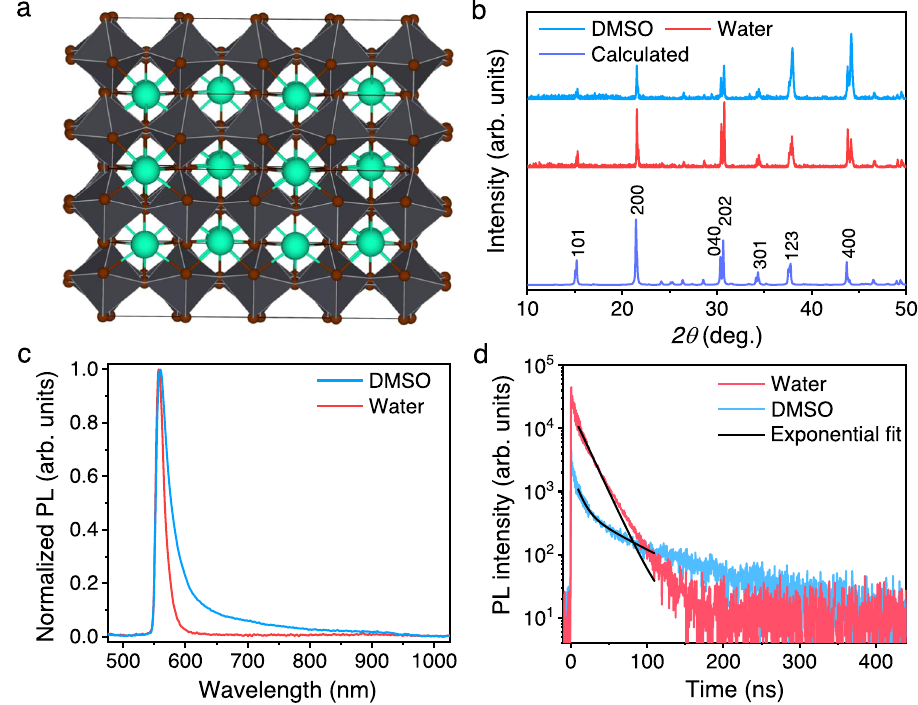
Fig. 2 Characterization of CsPbBr 3 single crystals. a Illustration of the crystal structure of CsPbBr 3 , b Comparison of the powder X-ray diffraction (XRD) of the DMSO and water grown SCs and the predicted pattern simulated from single-crystal diffraction. c Photoluminescence spectra. d Time-resolved PL decay of CsPbBr 3 SCs grown in DMSO and